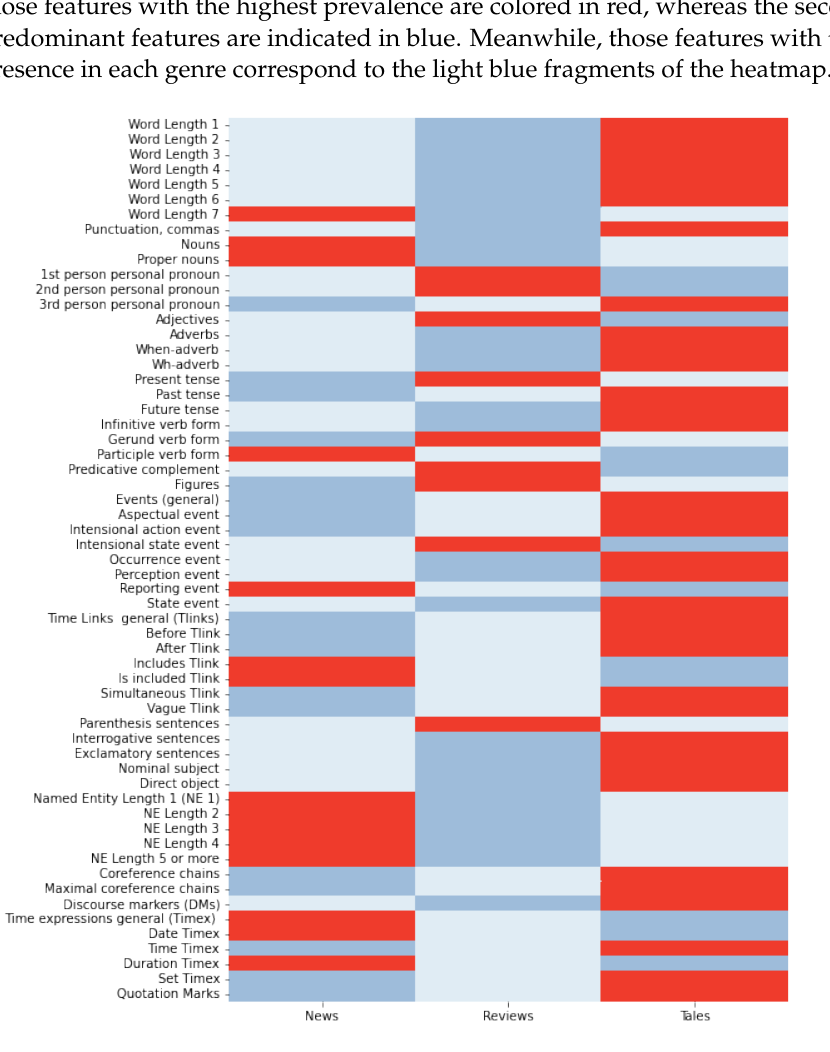
Figure 1. Heatmap showing the prevalence of features per